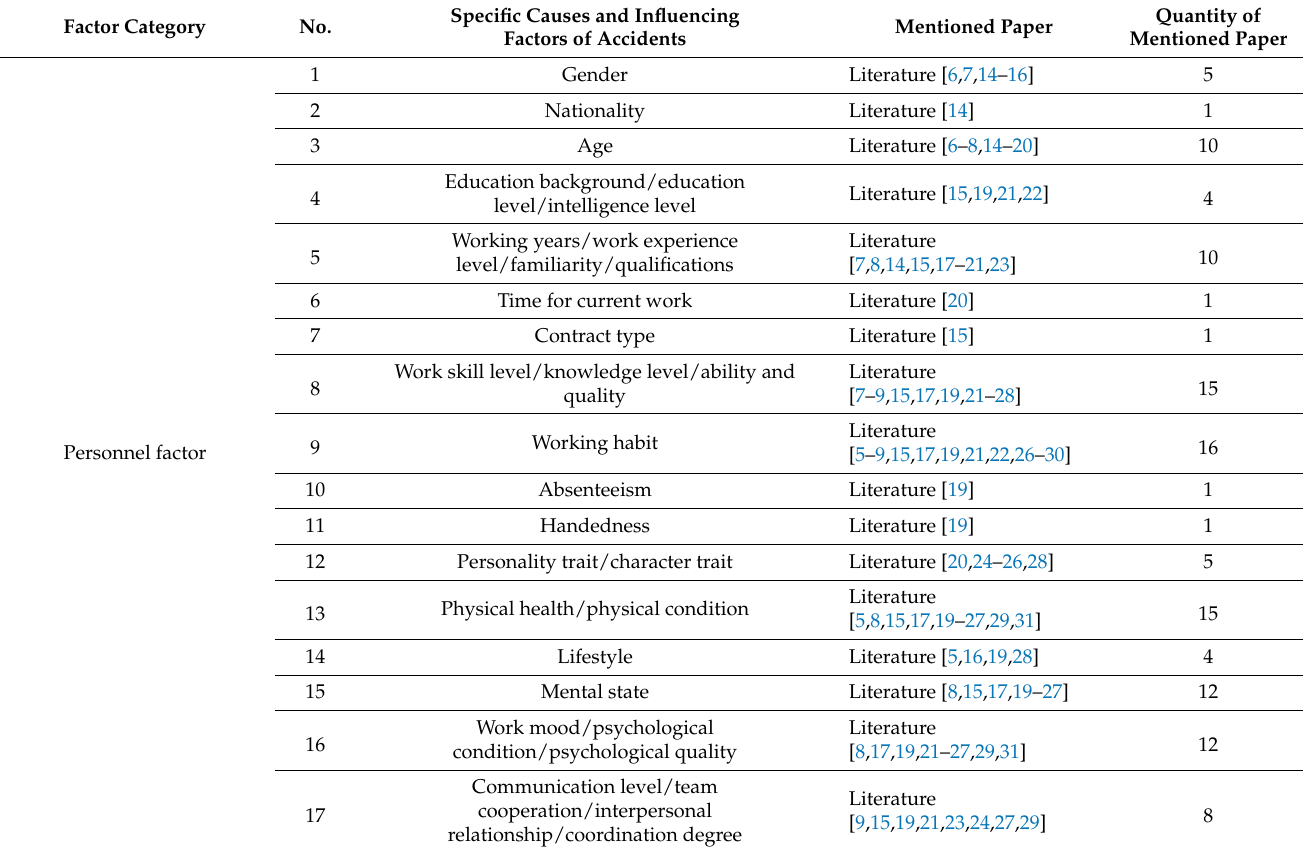
Table 1. Analysis and Statistical Results of Causes and Influencing Factors of Electric Power Personal Casualty Accidents in the Related Literature. Factor